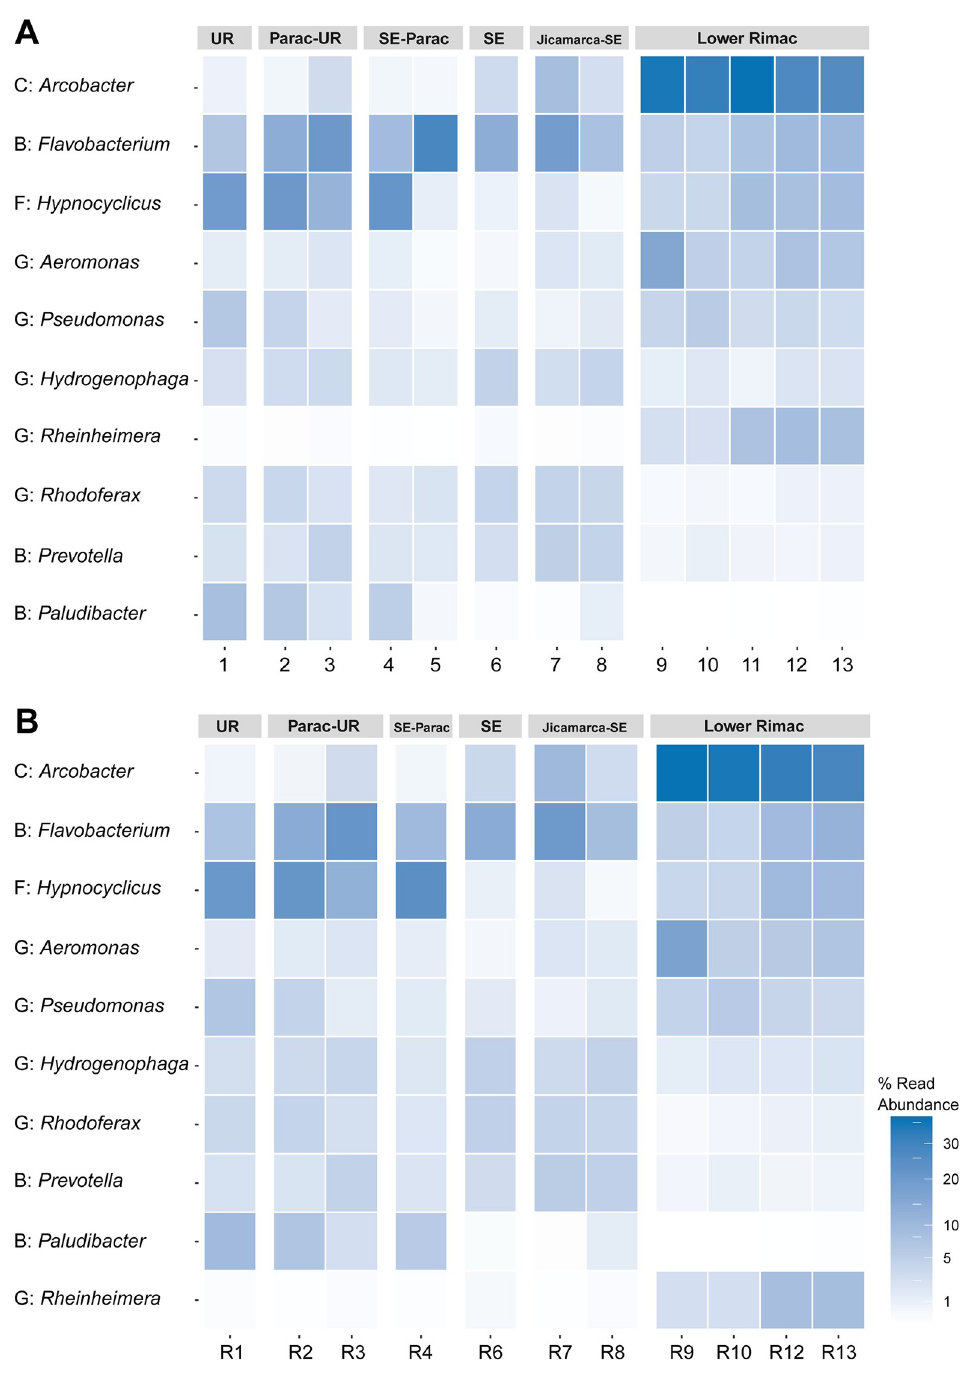
Fig 5. Heatmap of the abundance from the ten most frequent bacterial genera. Classes codes: B, Bacterioidota; C, Campylobacteria; F, Fusobacteriia; G, Gammaproteobacteria. Samples are numbered according to the information in Fig 1. UR: Upper Rimac, SE: Santa Eulalia. A. Samples, B. Replicates.